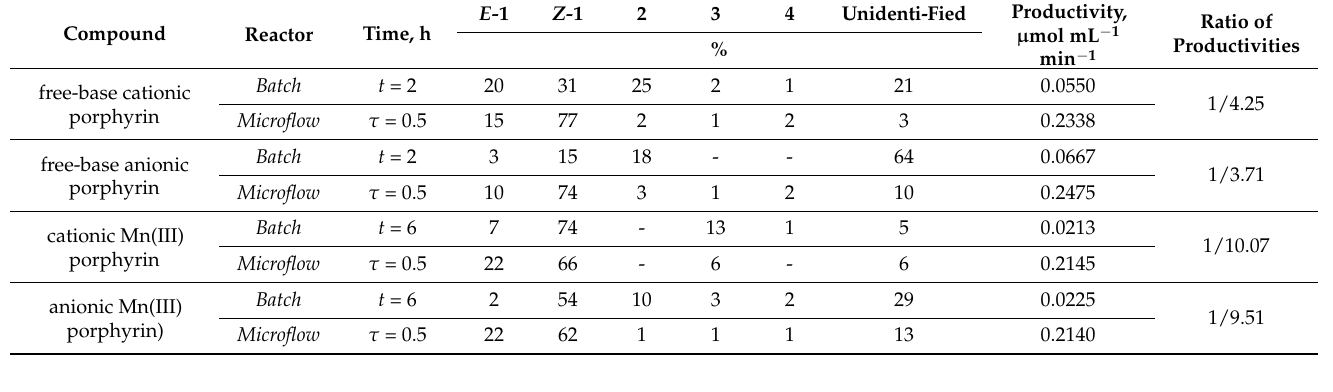
Table 3. Yields (%) of photoproducts obtained using Mn(III) and free-base cationic/anionic por- phyrins and the remained E - 1 for reactions performed in a batch reactor and microflow reactor (followed by UHPLC; t is time and it refers to a batch reactor and τ is residence time and it is a characteristic time dimension for flow reactor).